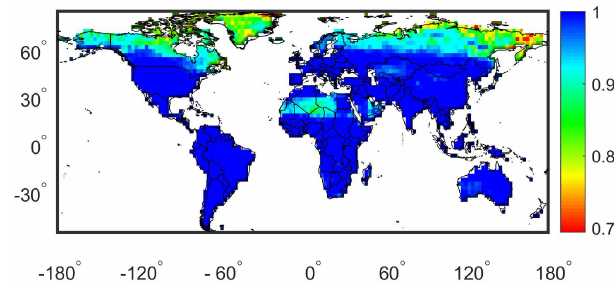
Figure 1. R 2 of Gaussian fit for NH 3 vertical